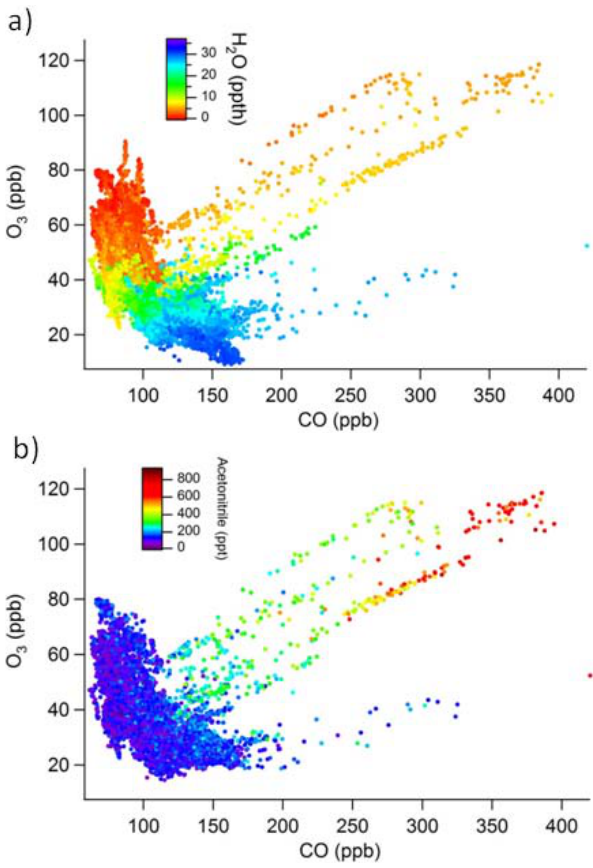
Fig. 8. Average tropospheric column densities of NO 2 (top) and HCHO (bottom) for July and August 2006 from